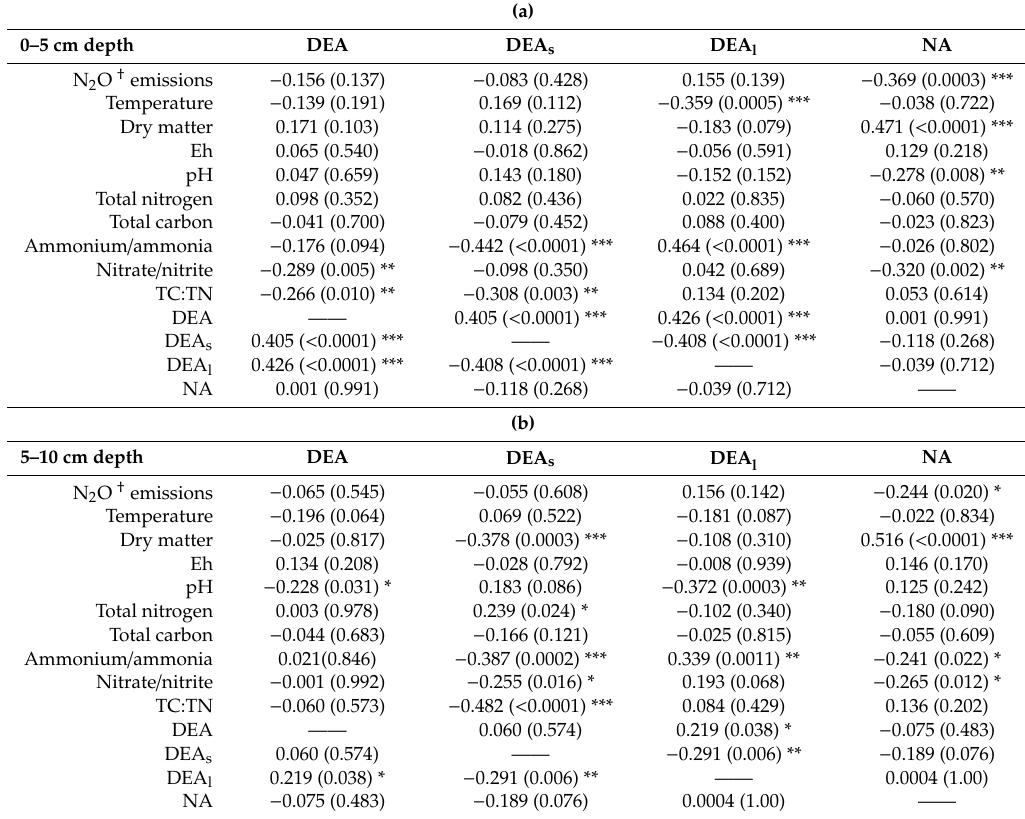
Table 3. Pearson’s correlation coe ffi cients ( R values) among measured parameters and denitrifier enzyme activity (DEA) and nitrification activity (NA). DEA–short (DEA s , 0–24 h incubation) and DEA–long (DEA l , 24–54 h incubation) were also analyzed at depths of ( a ) 0–5 cm and ( b ) 5–10 cm; p –values for each parameter are in parentheses. Asterisks indicate significance at * p ≤ 0.05, ** p ≤ 0.01, and *** p ≤